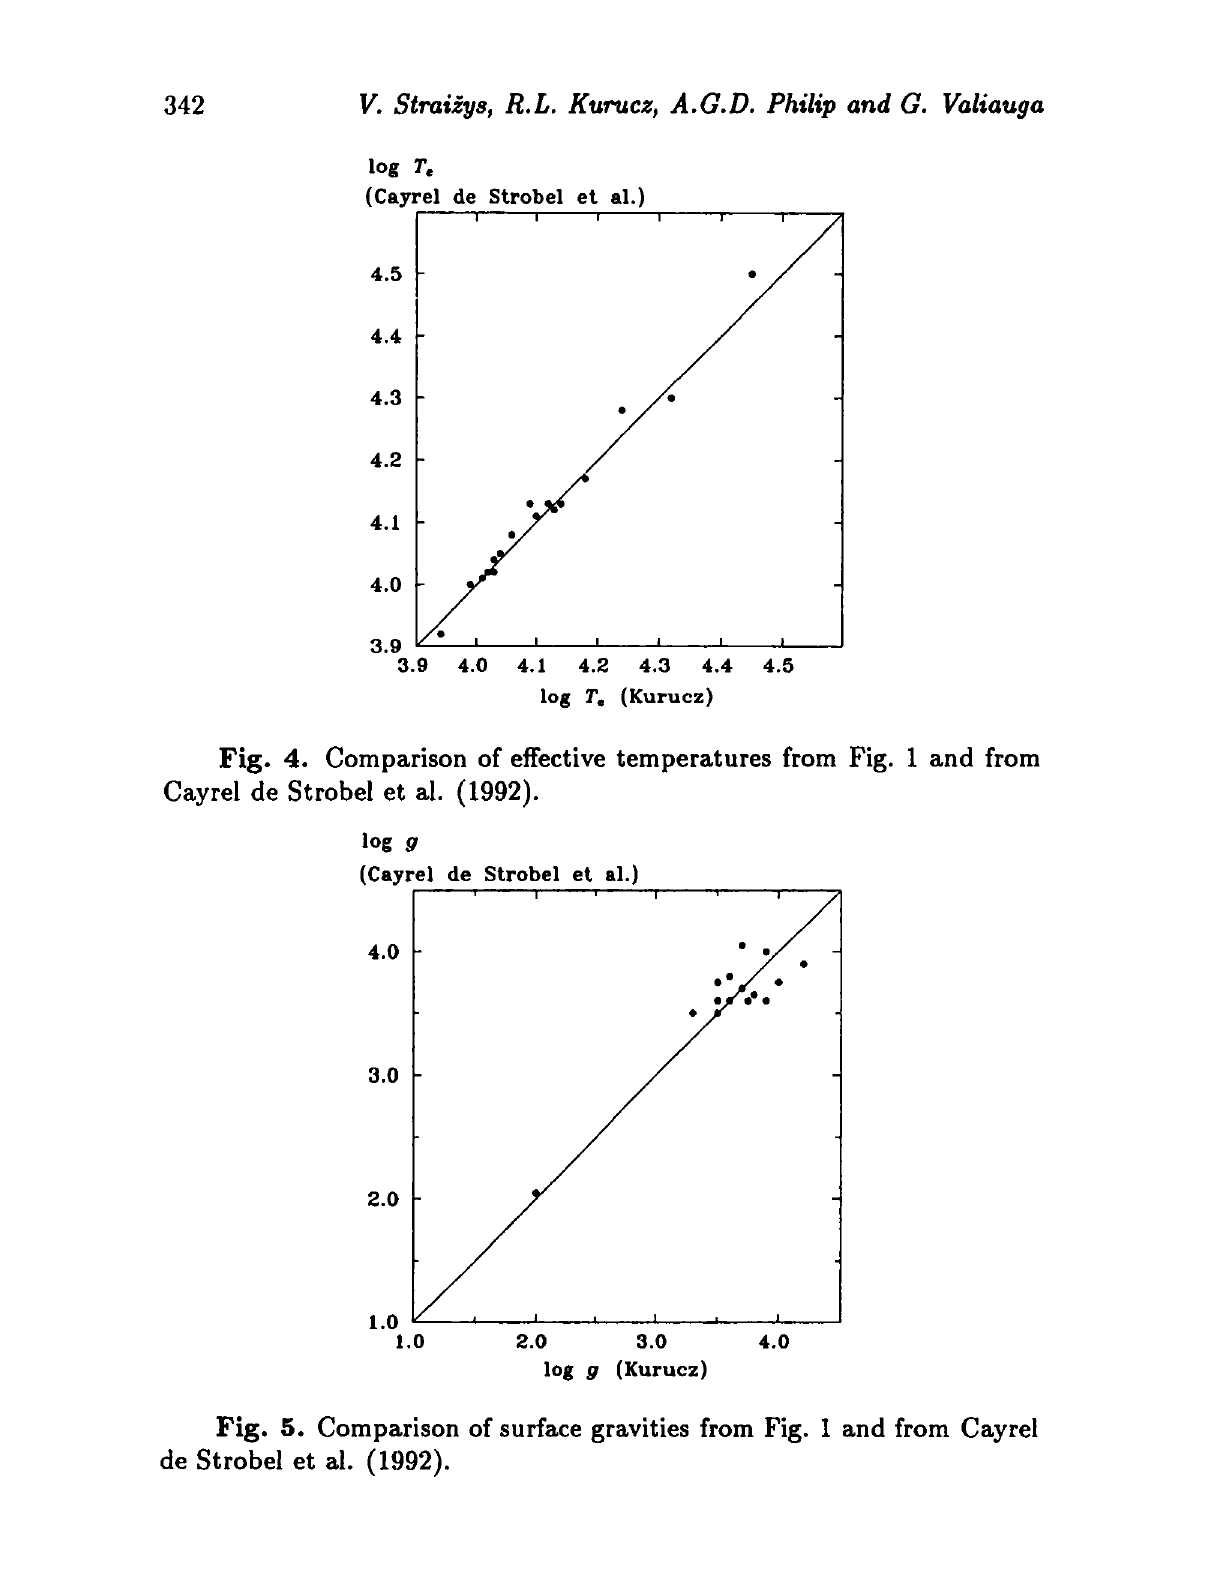
Fig. 5. Comparison of surface gravities from Fig. 1 and from Cayrel de Strobel et al.